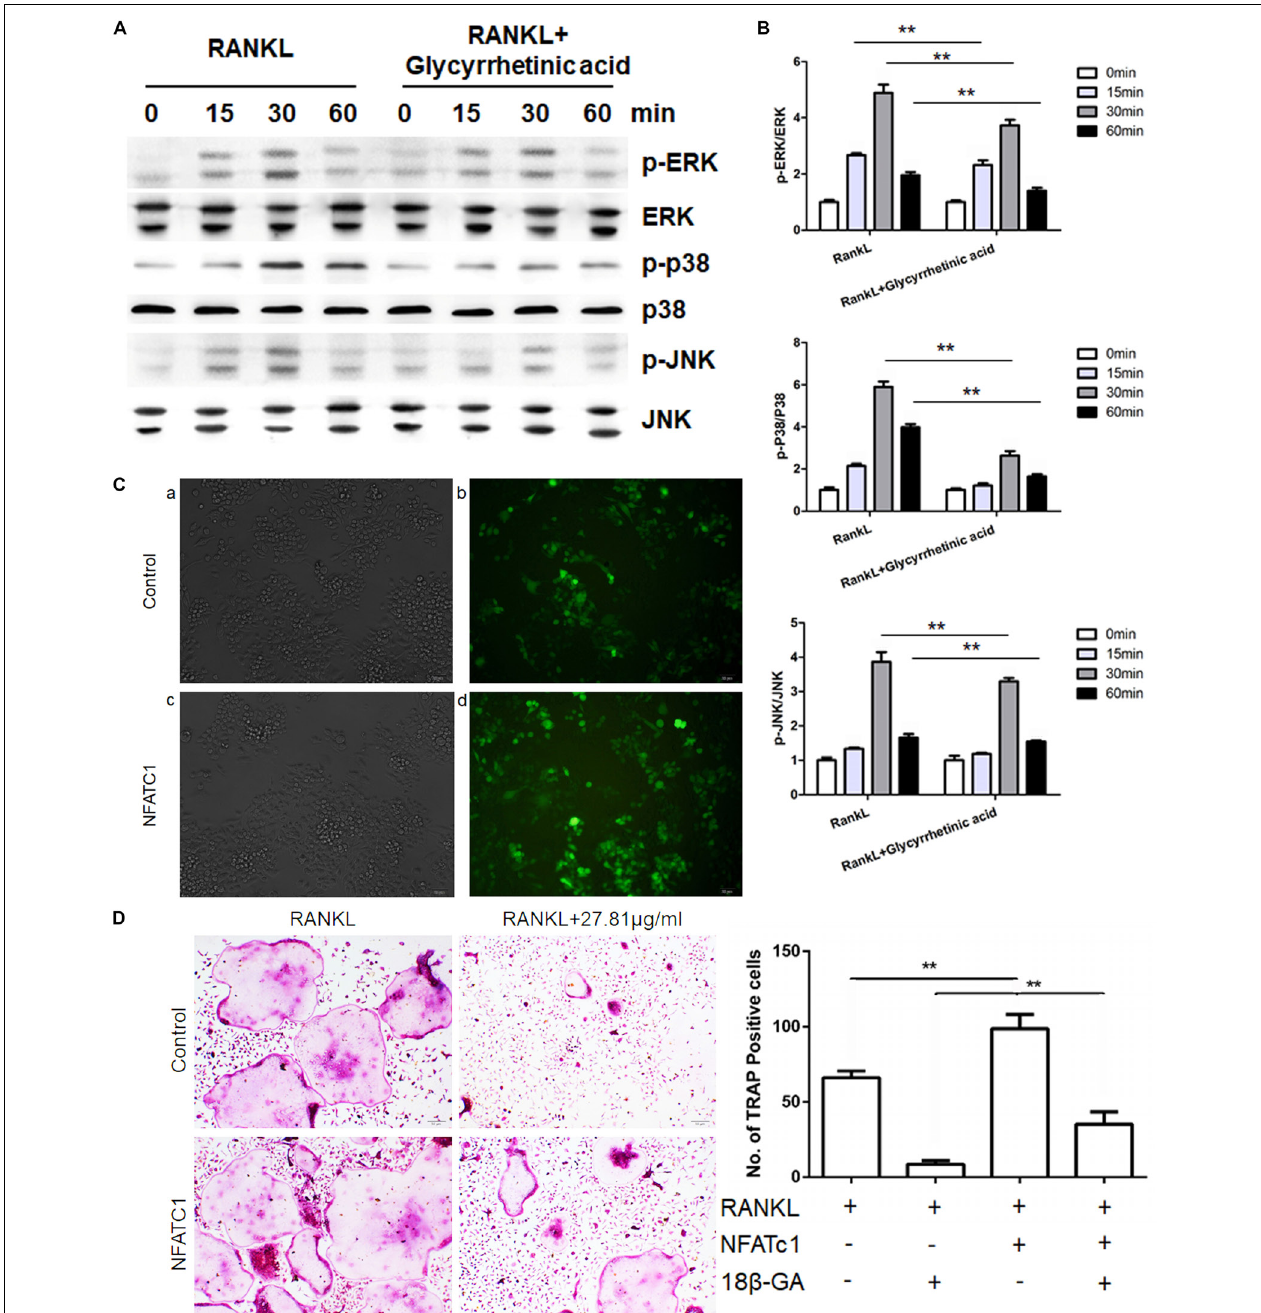
FIGURE 5 | 18 β -GA inhibits RANKL-induced activation of the MAPK pathway. (A,B) Phosphorylation of ERK, P38, and JNK, which was associated with the MAPK pathway. (C) Fluorescence of cells infected with lentivirus after 72 h. a, b was infected with Lv-shRNA-NFATC1 and c, d was infected with Lv-NFATc1. (D) Overexpression of NFATc1 could reverse the effect of 18 β -GA in